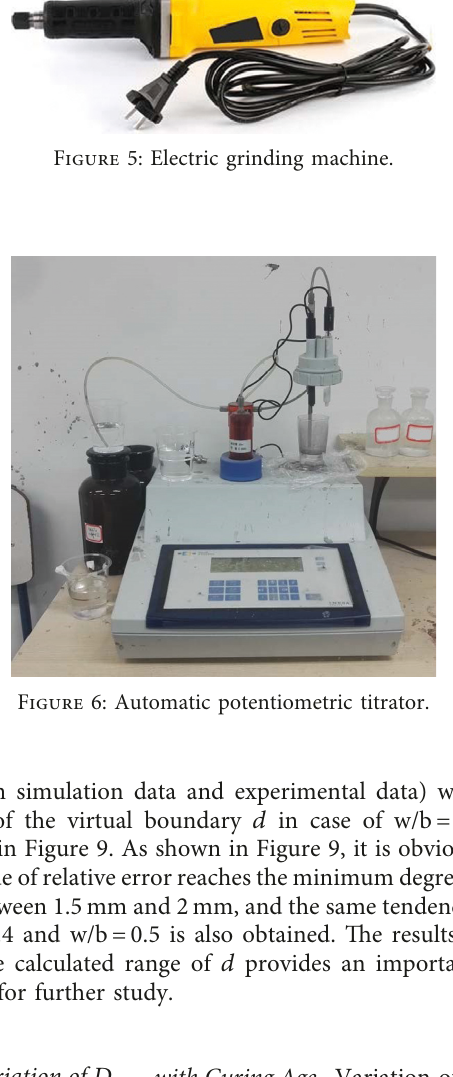
Table 2: Mixing proportions of mortar.